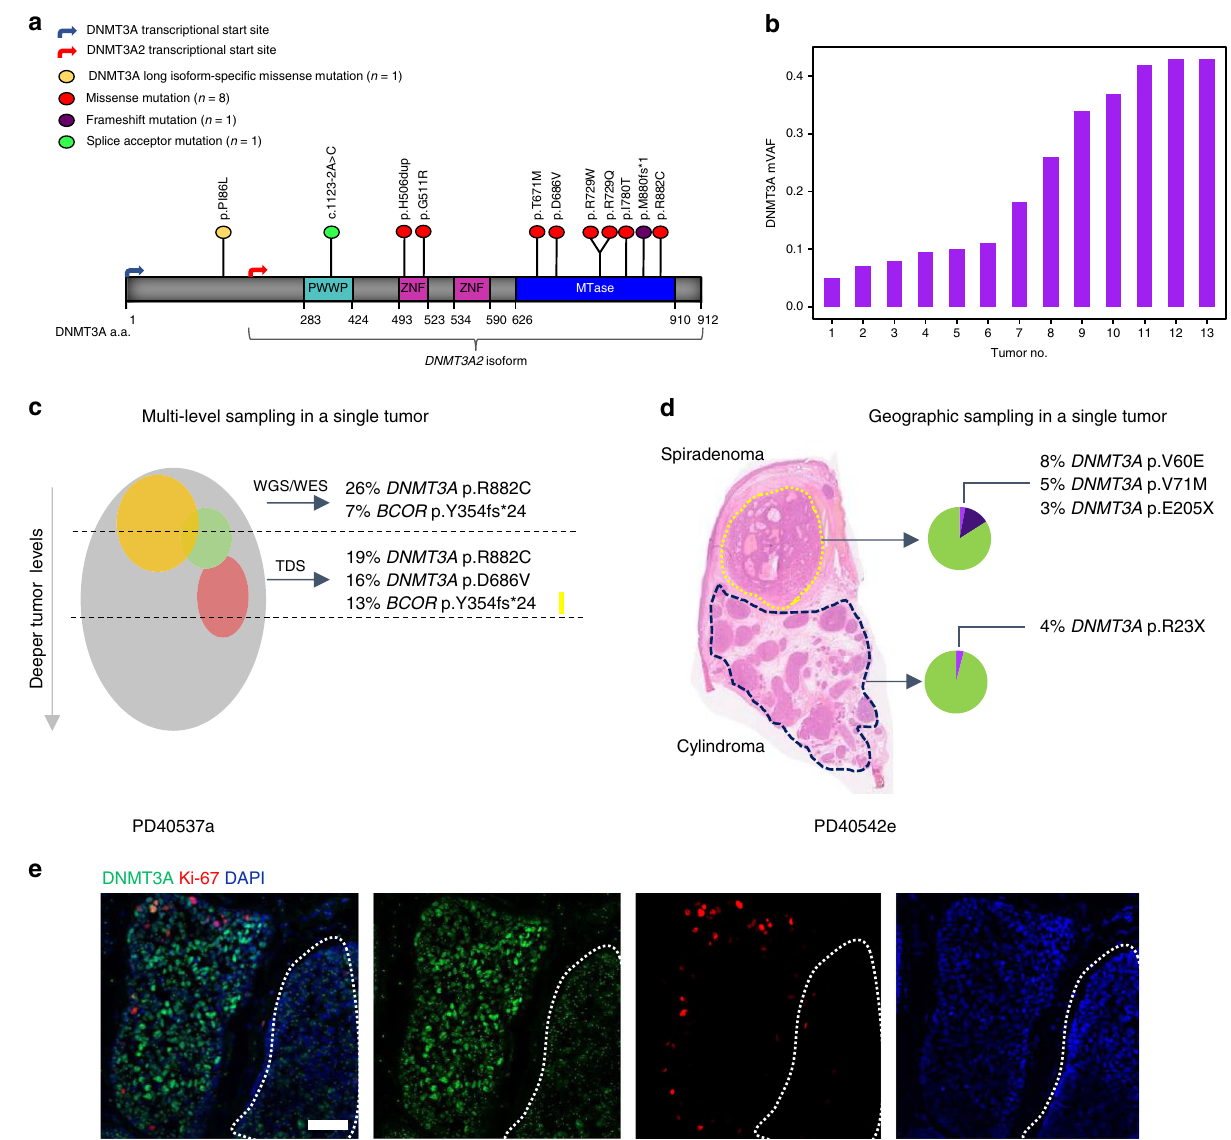
Fig. 2 Intratumoral heterogeneity of DNMT3A mutation in CCS tumors. a DNMT3A somatic mutation lollipop diagram for CCS tumors. b Spectrum of mutant variant allele fractions (VAF) of tumors in this study. c Sampling of additional, deeper slices from a single tumor (PD40537a) reveals intratumoral heterogeneity of DNMT3A mutations (tumor indicated with gray sphere, intratumoral clones with colored spheres). d Geographic sampling of distinct histophenotypes (of cylindroma and spiradenoma) within a single tumor section (PD40542e) highlights marked clonal heterogeneity particularly of DNMT3A mutations. e Protein expression of DNMT3A and Ki-67 is variable within a “ cylinder ” of CCS tumor and across cylinders. An adjacent outlined cylinder of cells shows loss of DNMT3A expression (white scale bar = 50 μ